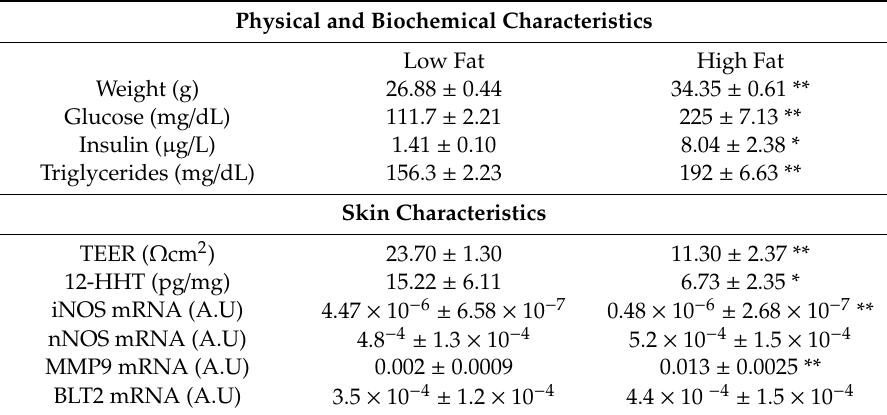
Table 1. General characteristics of the type 2 diabetic mice